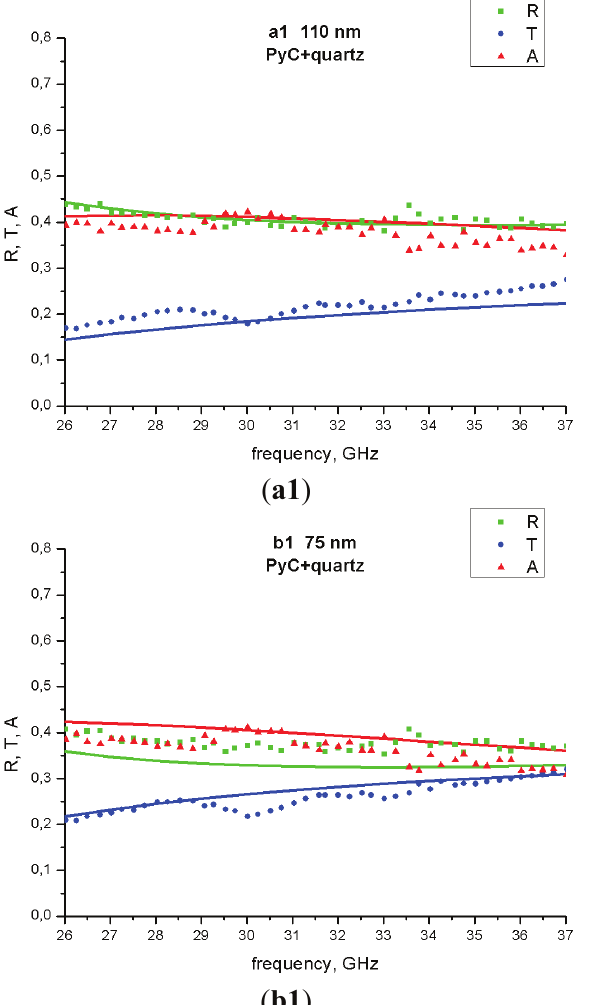
Figure 3. Calculated (solid lines) and measured (circles, squares and triangles) reflectance, transmittance and absorbance spectra of 110 nm ( a1 , a2 ) and 75 nm ( b1 , b2 ) thick films in the “PyC + quartz” ( a1 , b1 ) and “quartz + PyC” ( a2 , b2 )